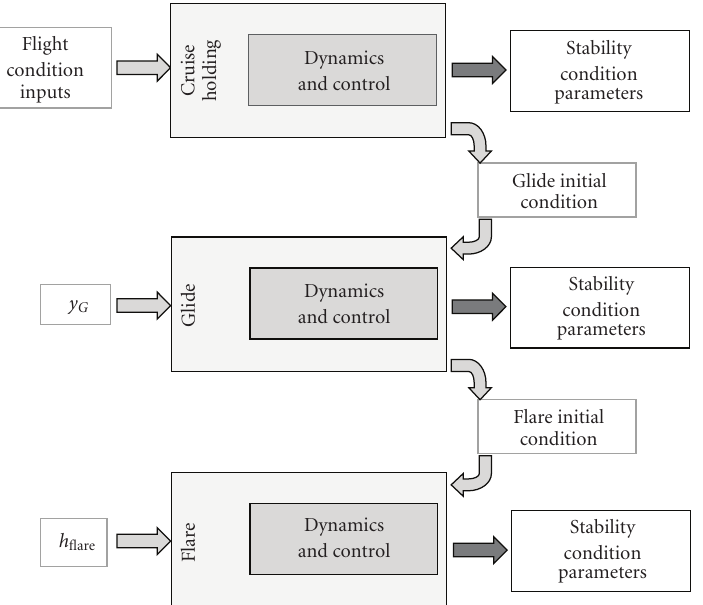
Figure 1: Data flow chart of the implemented flight